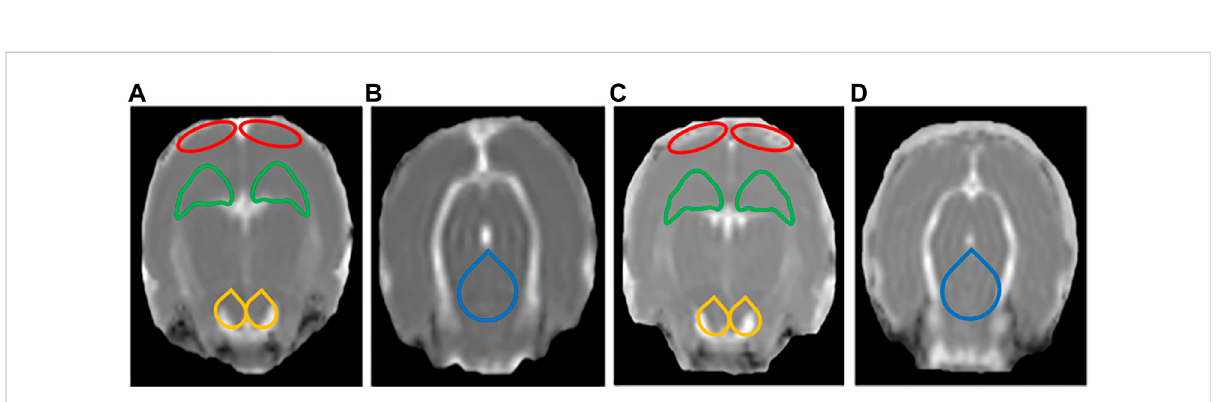
FIGURE 6 Display diagramof MDvalues ( n =6). (A) Displaydiagram ofMDvalues intheprefrontalcortex(PFC),hippocampus (HIP), andventraltegmental area (VTA) in the control group. (B) Display diagram of MD values in the dorsal raphe nucleus (DRN) in the control group. (C) Display diagram of MD valuesinthePFC,HIP,andVTAintheLPS-4dgroup. (D) DisplaydiagramofMDvaluesintheDRNintheLPS-4dgroup.Theredoutlinesindicatedthe PFC, the green outlines indicated the HIP, the yellow outlines indicated the VTA, and the blue outlines indicated the